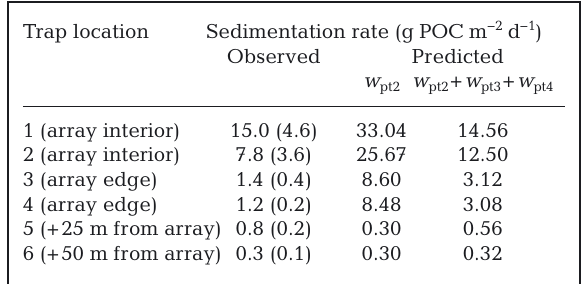
Table 5. Observed sedimentation rates (n = 4) (mean and SE in parentheses) at 6 locations at Farm B (19−24 August 1990) in Bliss Harbour (Fig. 1) from Hargrave (1994) compared to predicted maximum total POC sedimentation in model cells corresponding to trap mooring positions. Traps were sus- pended at 13.5 m, the value used for mean lowest normal tide depth (Z m ). Current statistics account for net-pen drag and near-bottom current acceleration effects (depth-average U ⁻ mean = 8.21 cm s −1 ) (Table 2) applied for model scenarios with 1 and 3 fecal size fractions (w) (Table 1). Grid resolution is 6 × 6 m in a 36 ha model area. POC flux +50 m from the net-pen array, considered to be background sedimentation, is included in predicted values. Fecal size fractions are de- scribed in Table